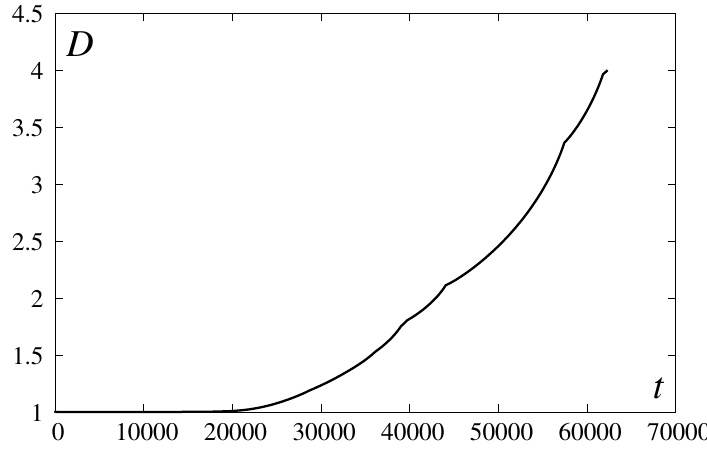
( 0 ) vs. t for the model (10)–(12); G = 0.002, N = 2 15 . t